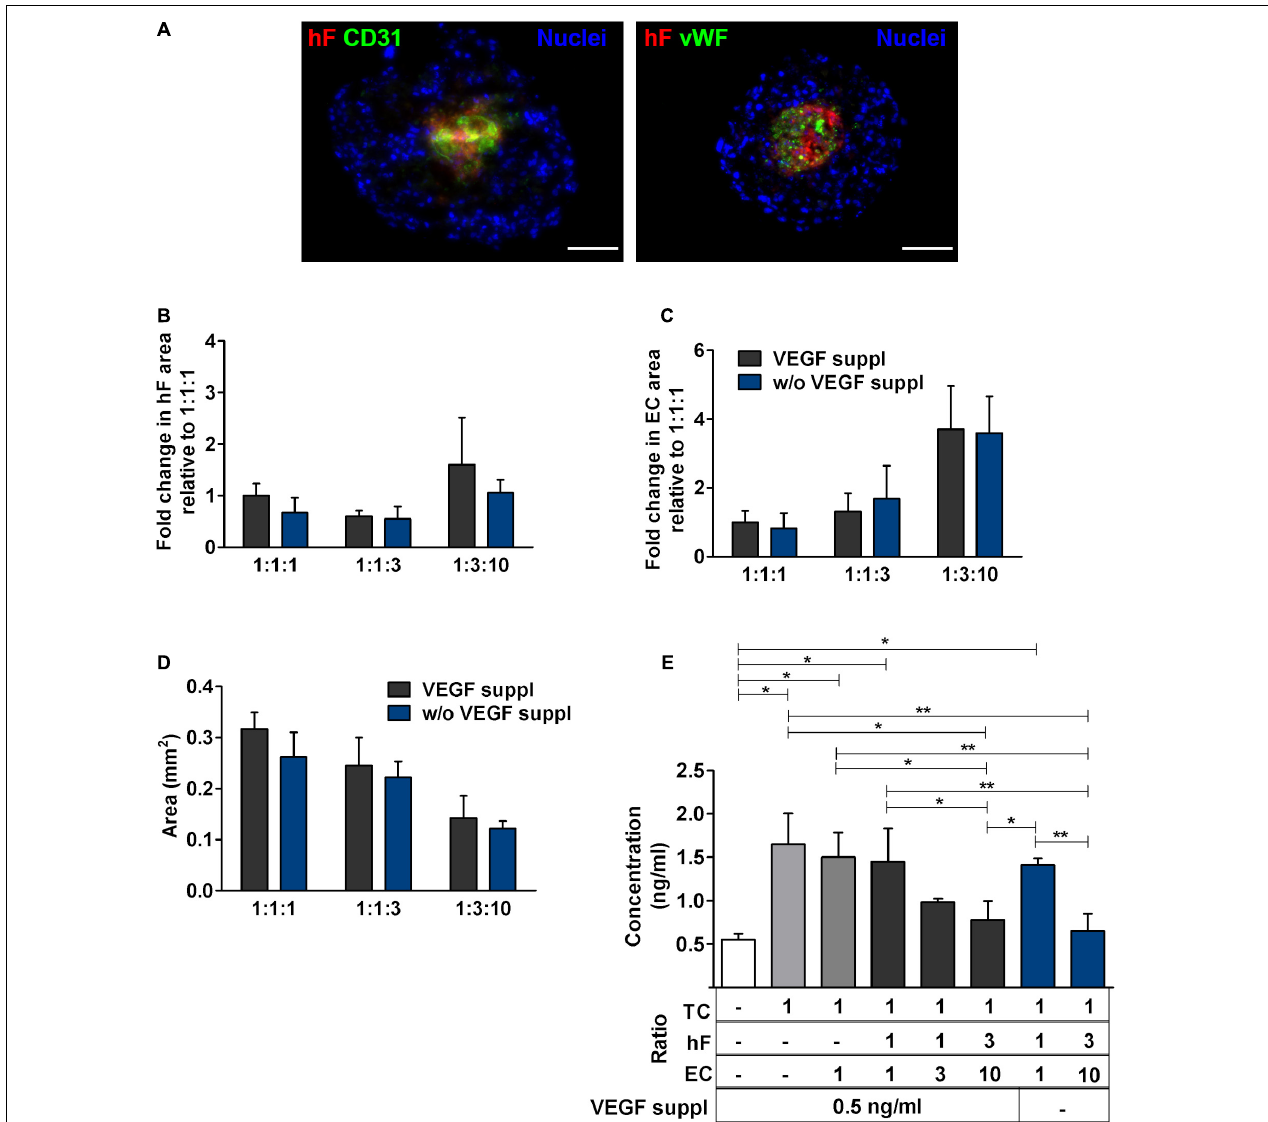
FIGURE 5 | Medium supplementation with vascular endothelial growth factor (VEGF) was not required for EC maintenance in triple heterotypic spheroids. (A) Immunofluorescence microscopy on cryosections of spheroids, collected at day 30 of culture (2 days of static culture followed by 28 days of agitation-based culture, rotational speed of 100 rpm). Detection of the EC markers, CD31 (green) and von Willebrand factor (vWF, green), in spheroids cultured with supplementation of VEGF (0.5 ng/ml), or without (w/o VEGF supplementation); nuclei were labeled with DAPI (blue). Spheroids generated by seeding 6,000 cells per well of HCC1954 breast tumor cells (TC); human dermal fibroblasts, labeled with PKH26 (hF, red); HUVEC (EC), at a TC:hF:EC ratio of 1:3:10. Images are representative of the 5–10 spheroids assessed per condition, in each of the three independent experiments performed. Scale bar, 100 µ m. Quantification of (B) fold change in hF area, (C) fold change in EC area, and (D) total spheroid area at the equatorial axis, for spheroids from A. The EC and hF areas were normalized for the total spheroid area at the equatorial axis; the fold change was determined relative to the condition with a TC:hF:EC ratio of 1:1:1, with VEGF. Data are presented as mean ± SD from N = 3–4 (independent experiments); in each experiment, at least 20 spheroids were quantified per condition. Statistical analysis was performed using unpaired t -test two-tailed comparing VEGF supplemented to VEGF not supplemented for each cell ratio; no statistical significance was found. (E) VEGF concentration in the spheroid culture supernatants from day 30, quantified by ELISA. White bar represents fresh culture medium. Data presented as mean ± SD from three to four independent experiments ( N = 3–4). Statistical analysis was performed by one-way ANOVA followed by a post hoc Tukey’s multiple-comparison test; * p < 0.05; ** p < 0.01; for each ratio, no statistical significance was found between conditions with and without VEGF supplementation at each cell